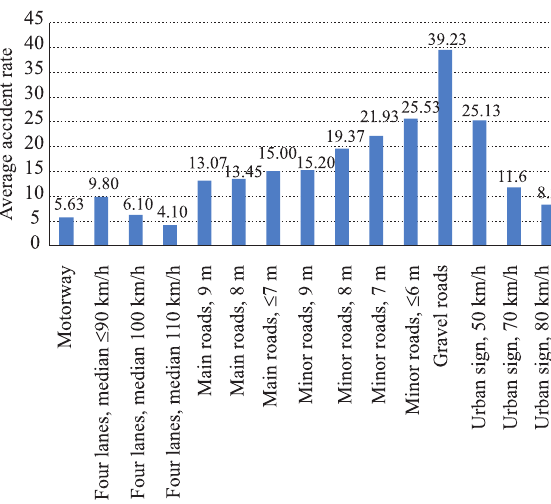
Fig. 3. The average accident rate of the road groups (data of